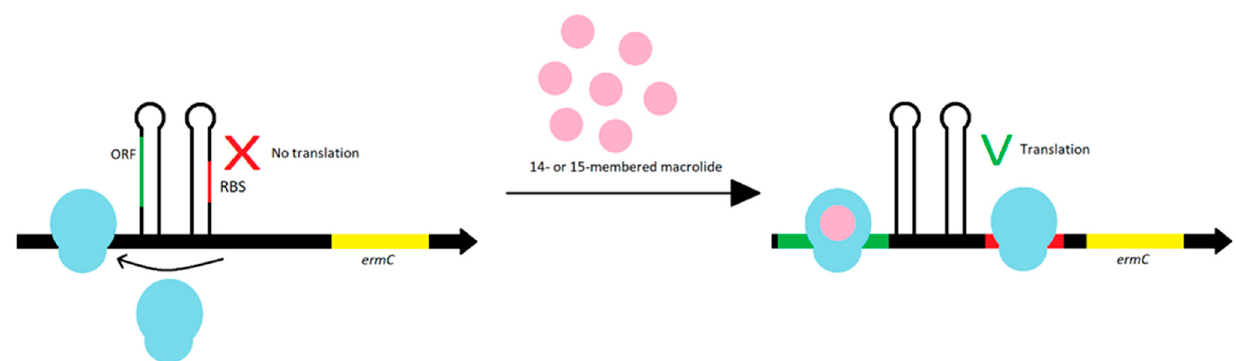
Figure 9. The ORF at the start codon synthesizes leader peptides. The ORF translation leads to the formation of stamped structures, which prevents the ribosome from binding to RBS. In the presence of an inducer, translation of the leader peptides is inhibited, with the ribosome binding to RBS, and translational of resistance genes may occur.